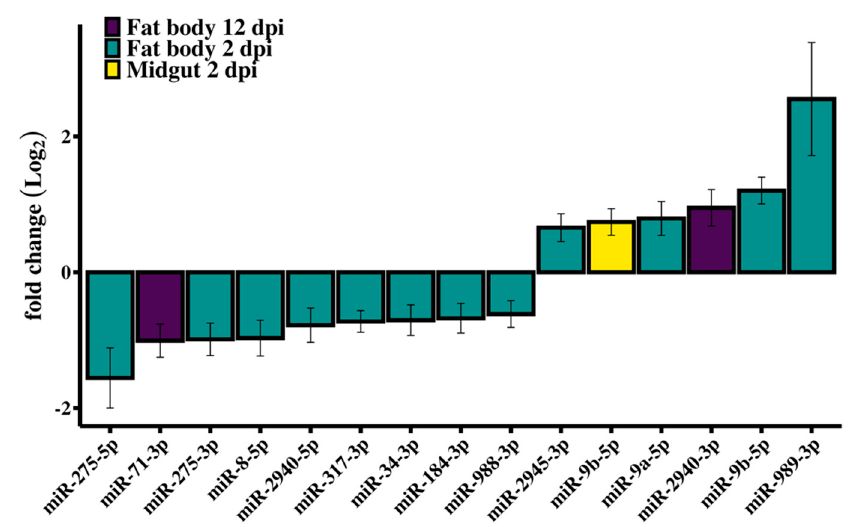
Figure 3. RRV caused differential expression of Ae. aegypti miRNAs. Log 2 fold changes of miRNA expression following infection with RRV at 2 dpi in fat body (green) and midgut (yellow) and in fat body at 12 dpi (purple). Error bars represent the standard error of the mean of biological replicates ( N = 3).